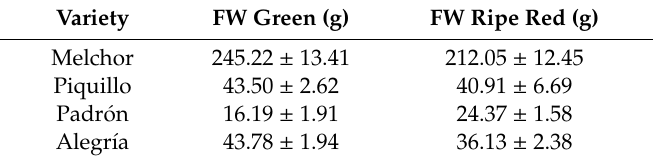
Table 1. Fresh weight (FW) of whole fruits from four pepper varieties at two ripening